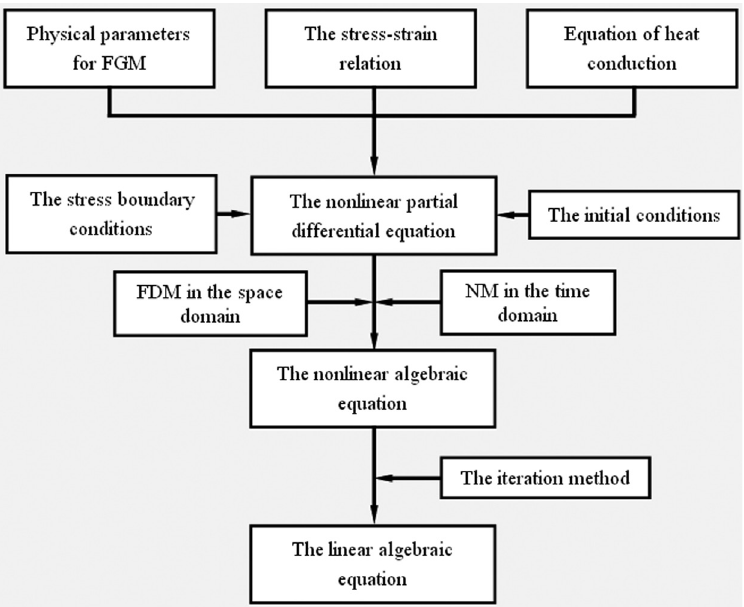
Table 1 Flowchart of solving techniques for the dynamic